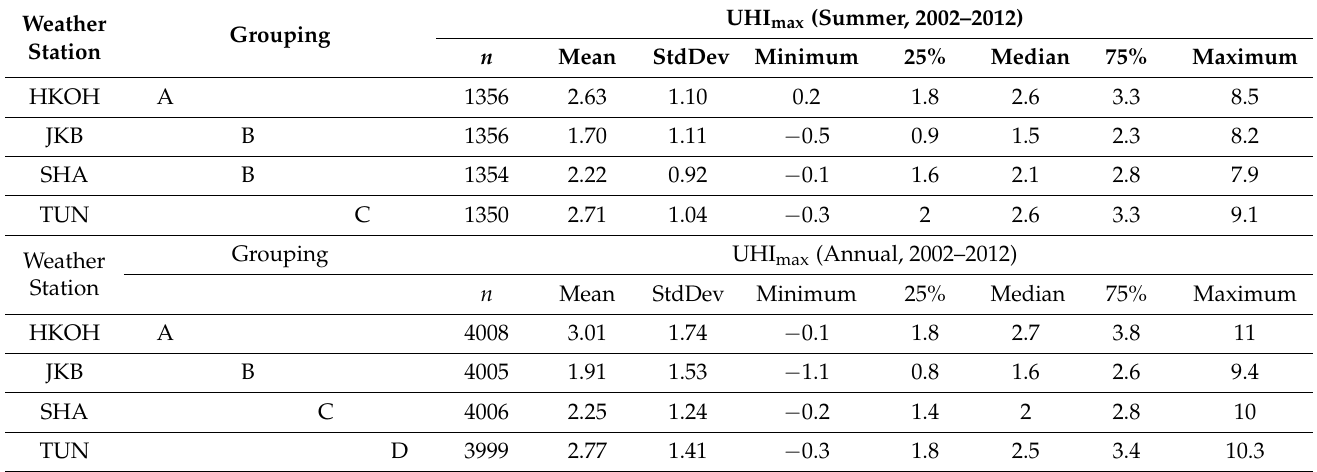
Table 2. Statistics of UHImax observed at four urban stations in summer and the whole year using the one-way ANOVA test (2002–2012, incomplete observations were excluded, and n corresponds to the number of daily observations during the study